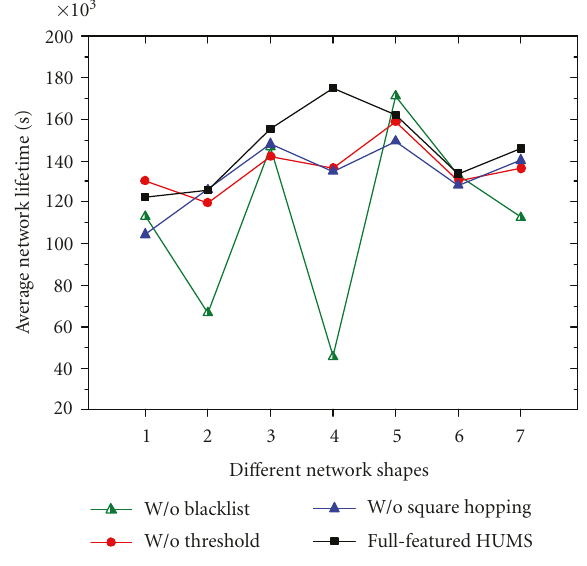
Figure 12: Network lifetimes varied with di ff erent network shapes. (The initial energy for each node is 8J.)